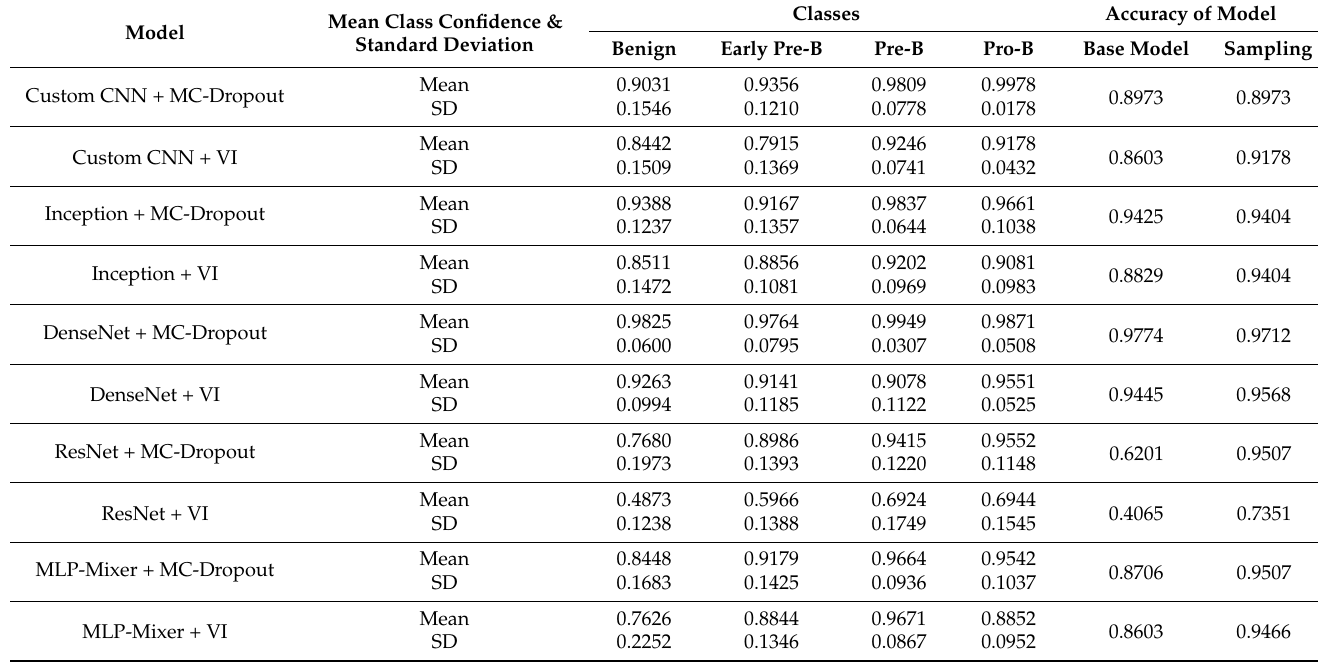
Table 1. Resultfootnotes of uncertainty quantification for different deep learning models used for the ALL